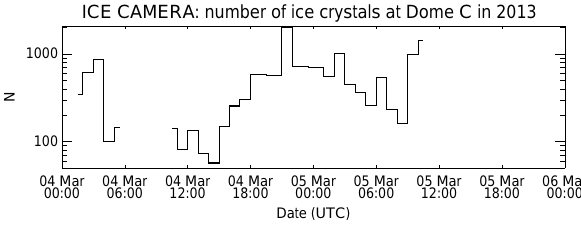
Figure 8. Time evolution of the number of ice crystals measured by the ICE-CAMERA integrated over 1h from 4 to 5 March 2013 above the Dome C